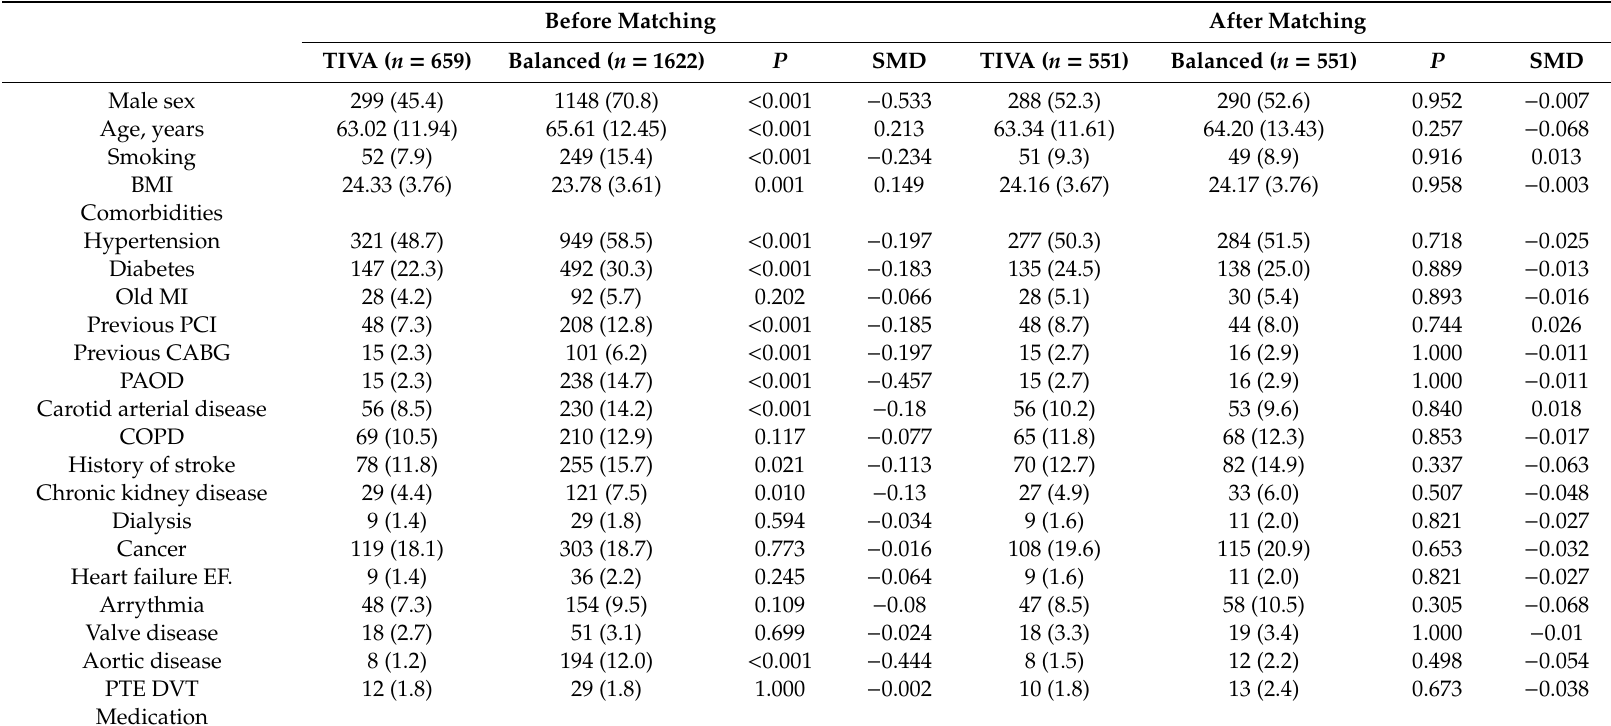
Table 2. Balance in clinical characteristics between the two groups before and after